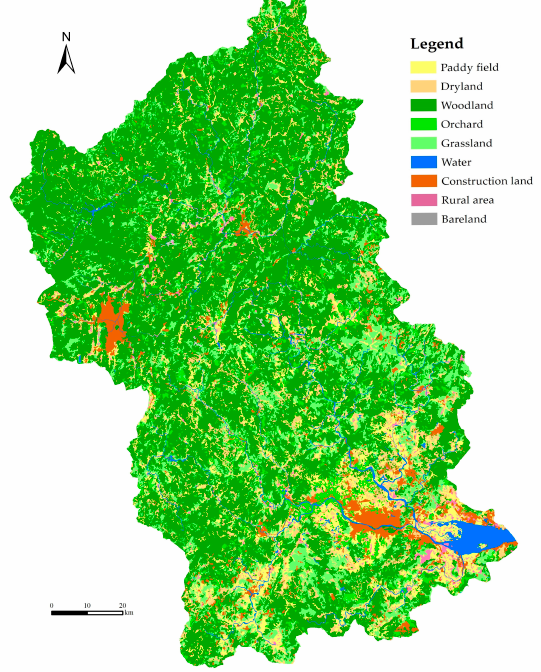
3 Figure 3. Landscape distribution of the Jiulong River watershed in